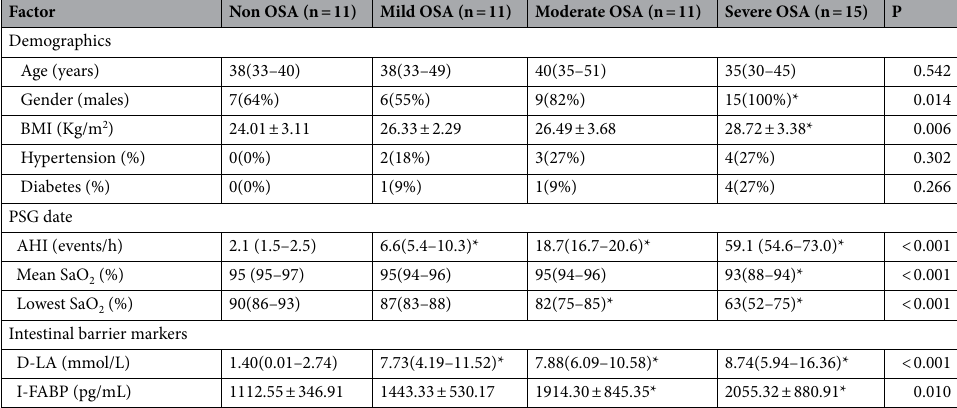
was identified. Higher AHI predicted higher relative abundance of Fusobacterium (B = 0.538, P = 0.041) and Peptoclostridium (B = − 0.491, P = 0.046), independent of age, BMI, and sex (Table 3).